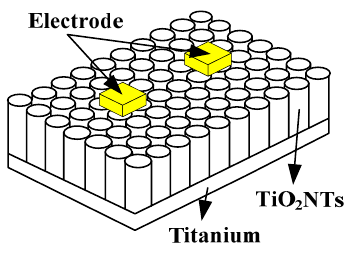
nanotube array 2